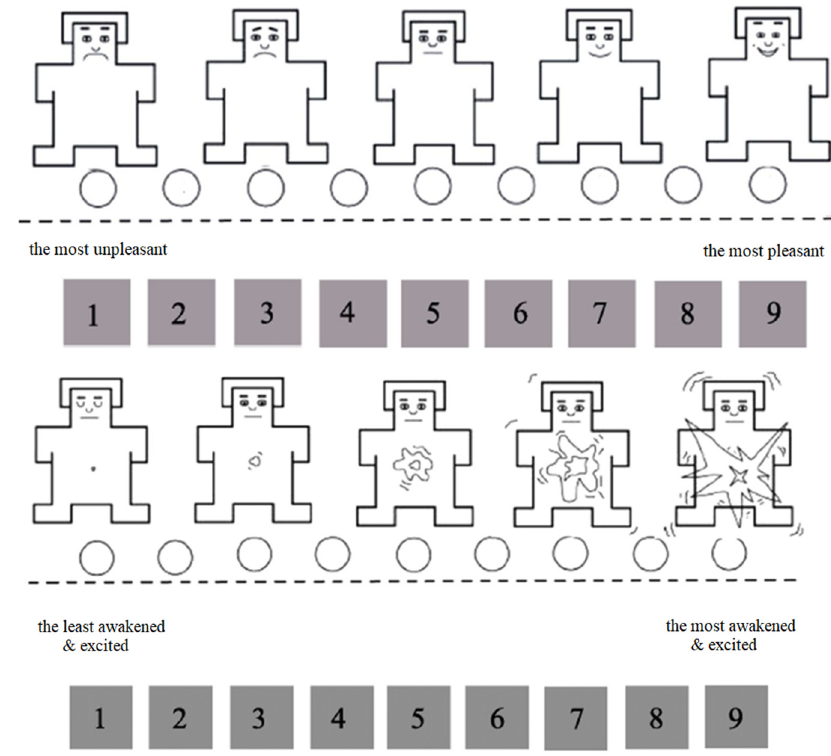
Figure 2. Pleasure and arousal evaluations.